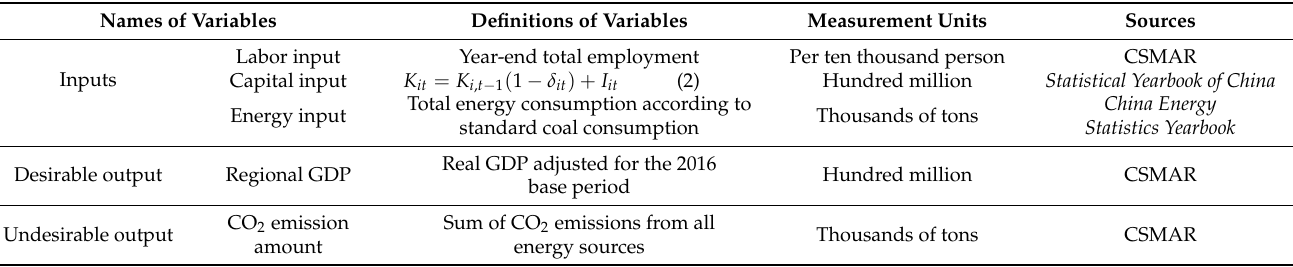
Table 1. Relevant variables of the